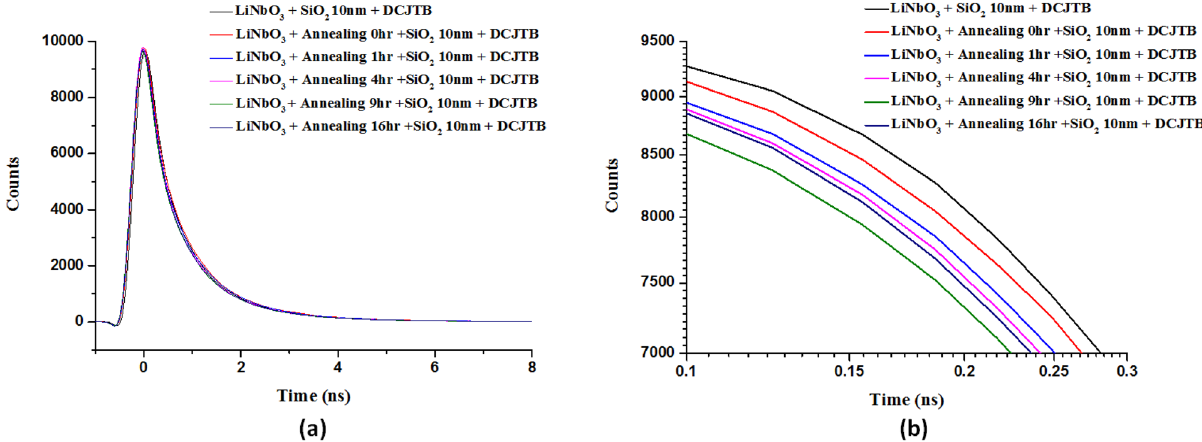
Figure 7. ( a ) Lifetime of the dye molecules (DCJTB with 75 nm) for the flat LiNbO 3 substrate and the fabricated PPE LiNbO 3 substrates under different annealing times of 0, 1, 4, 9, and 16 h, respectively. ( b ) Enlarged diagram of ( a ) in the time range of 0.1–0.3